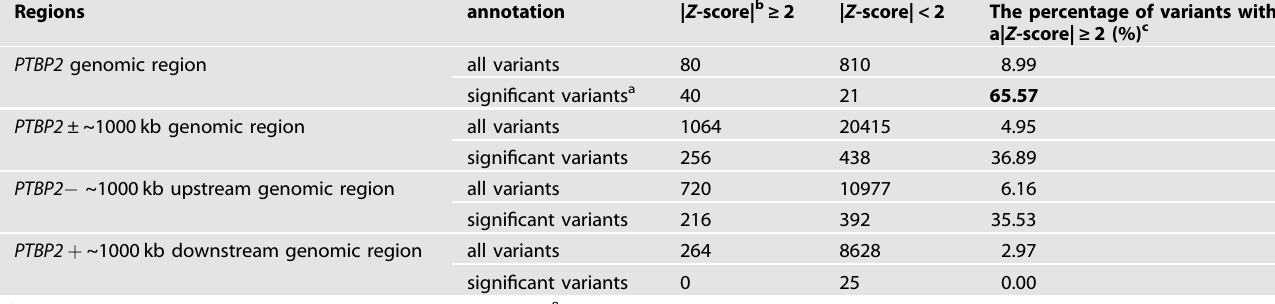
Table 3. Assessment of Z -scores from sex-strati fi ed BMI GWAS.